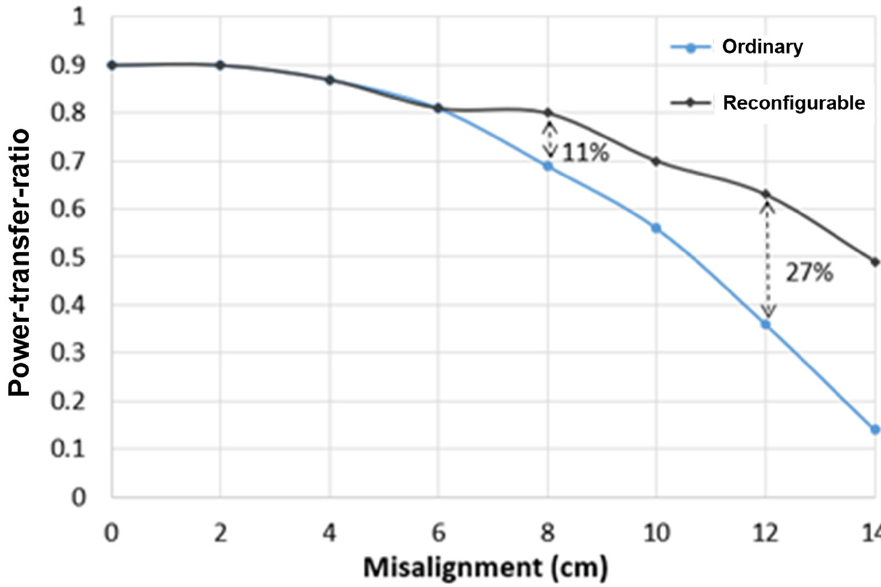
Figure 15. Measured power-transfer ratio from the transmitter coil to the receiver coil versus misa- lignment.